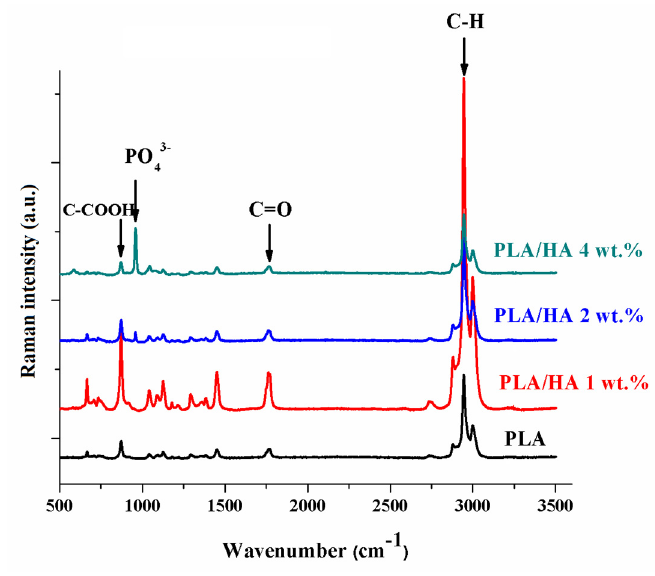
Figure 2. Raman spectra of PLA and PLA/HA composite films.